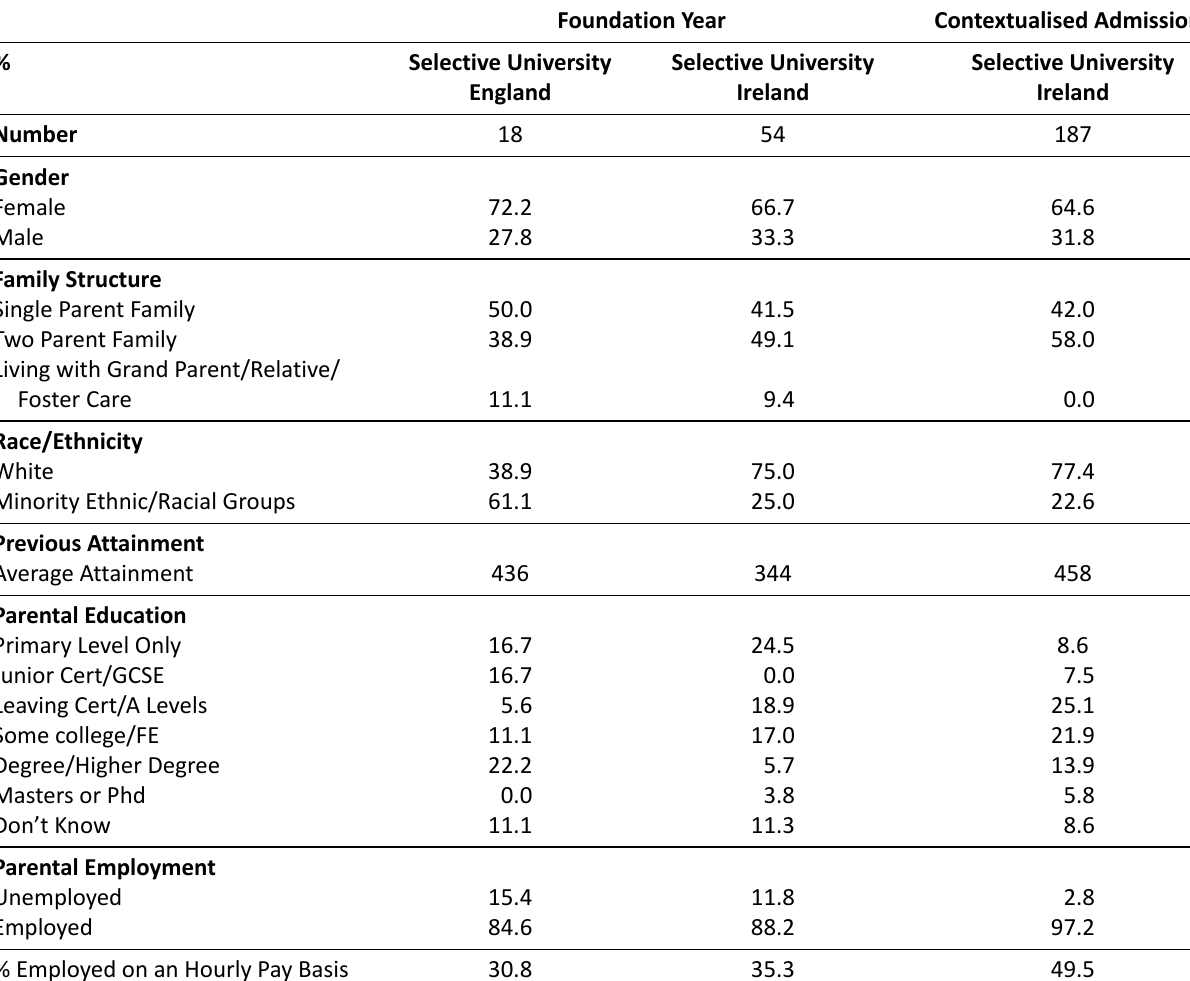
Table 2. Characteristics of Students Entering the WP Admission Routes in two selective universities in Ireland and the